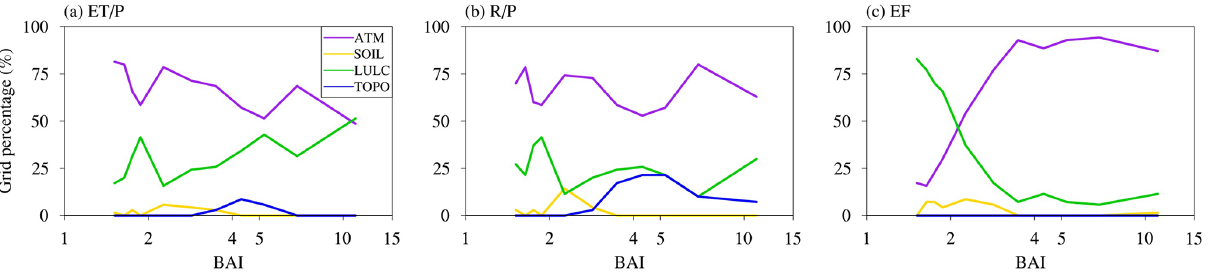
Figure 10. The grid percentage of dominant heterogeneity sources along with Budyko’s aridity index. A higher aridity index means more